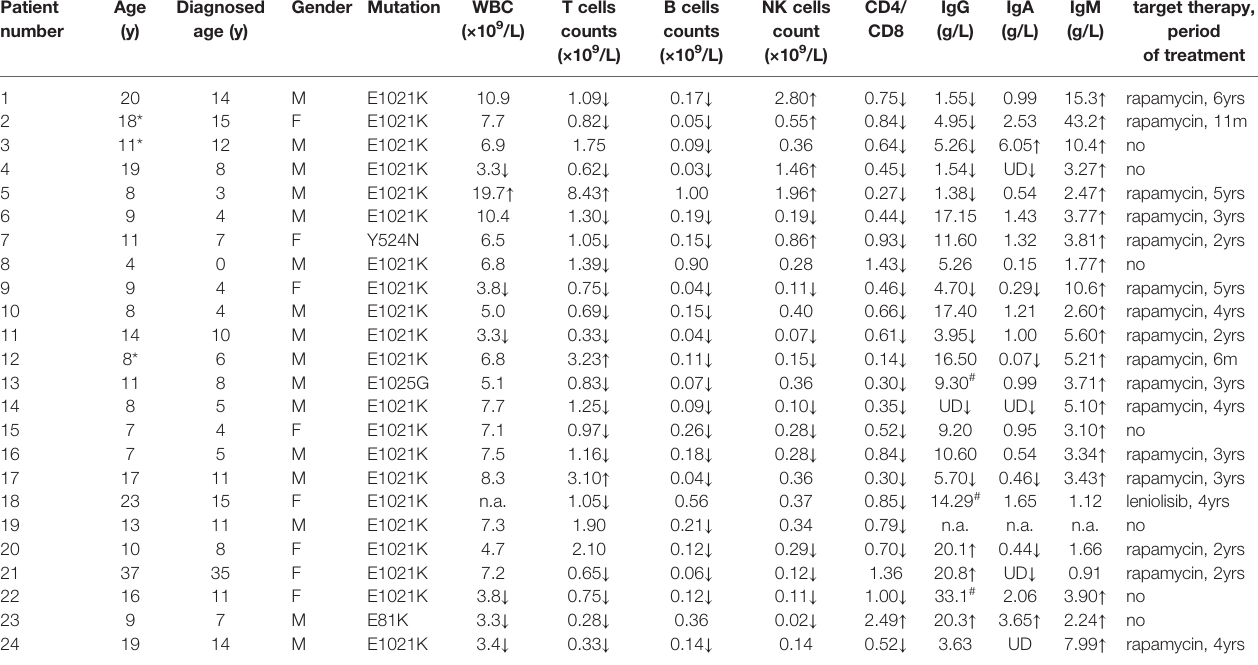
TABLE 1 | Routine immunological features in APDS